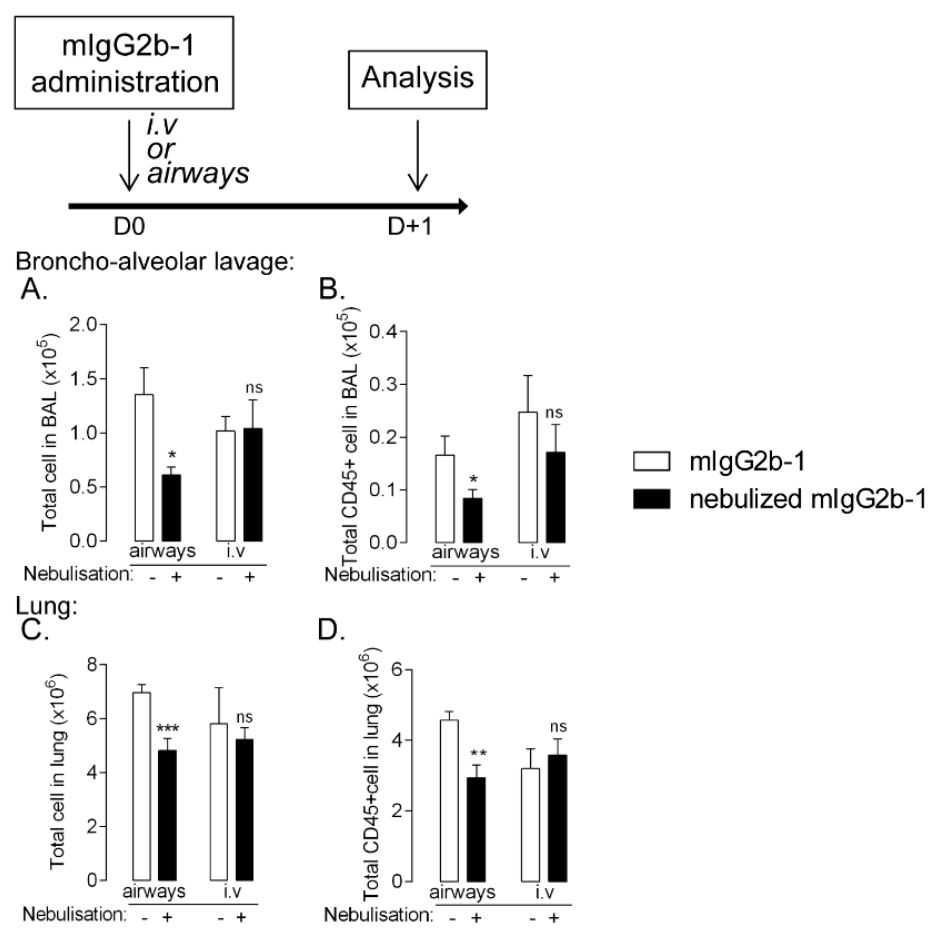
Figure 6. B6 mice received a 40 µ L orotracheal instillation or 100 µ L intravenous injection of mIgG2b-1 at 100 µ g/mL either native (white bars) or nebulized (black bars). The total number of cells ( A , C ) and CD45+ cells ( B , D ) were quantified in BAL ( A , B ) and in the lungs ( C , D ) using flow cytometry, 18 h after the administration. The data are quoted as the mean ± SEM. *, **, ***: p < 0.05, p < 0.01 and p < 0.001, respectively, in a t-test. The results are representative of two independent experiments ( n = 5 mice/experiment).